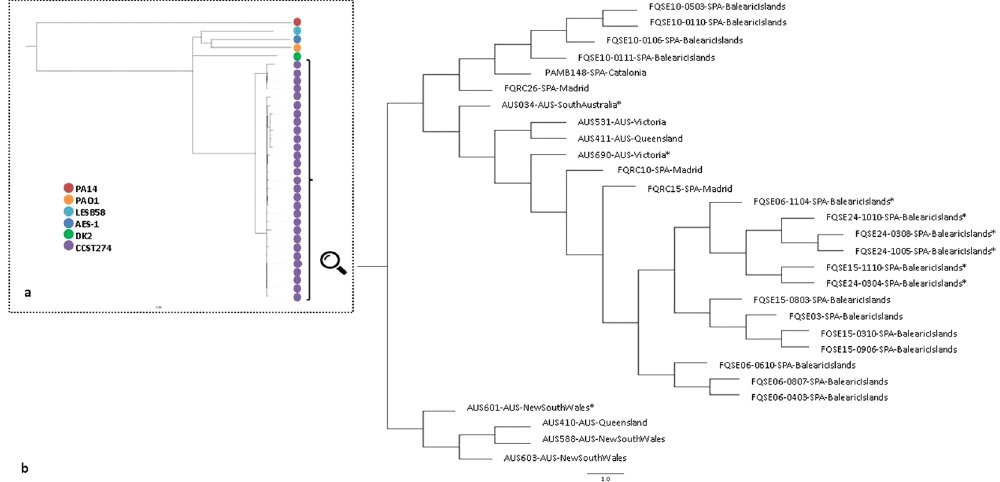
Figure 2. Core-genome phylogenetic reconstructions of P . aeruginosa CC274 CF clone. ( a ) Genetic relationship between CC274 and other well-recognized CF epidemic clones. ( b ) Genetic relationship between the CC274 collection isolates. Both reconstructions were made with Parsnp using default parameters. Isolates are labelled according to the following format: Patient identification - MMYY isolation code in the case of sequential isolates - Country (AUS: Australia; SPA: Spain) - Region. Mutator isolates are identified with an